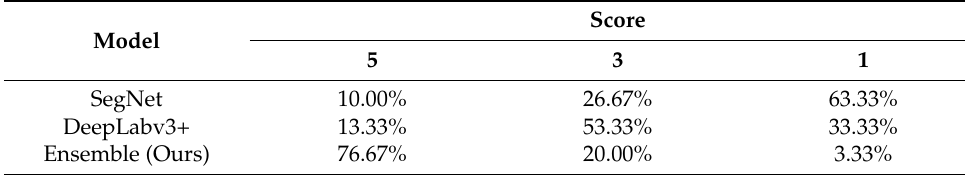
Table 4. Percentage of images with each score for each